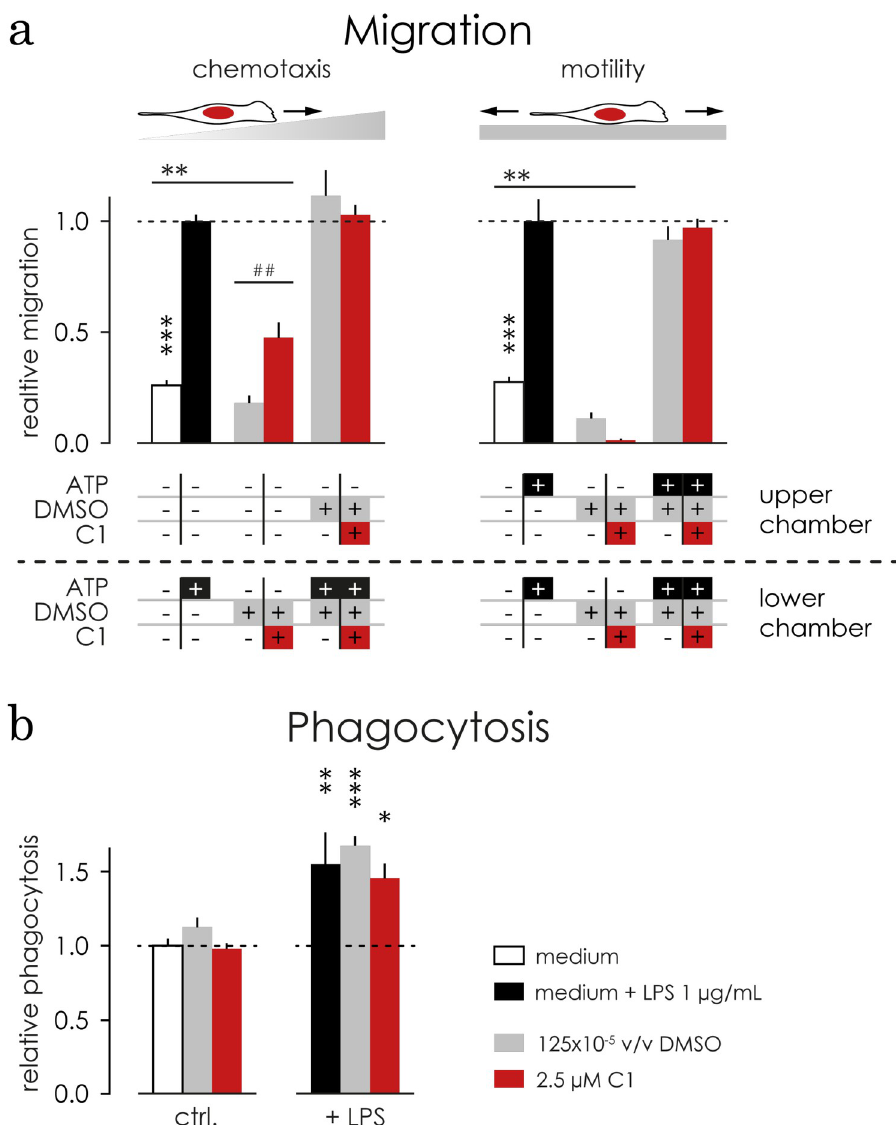
Fig 3. C1 acts as a chemoattractant but did not influence microglial motility and phagocytosis. a) C1 affected microglial chemotaxis. The results were normalized to ATP induced (black bars) chemotaxis or motility, respectively. A gradient of 2.5 μ M C1 (in red) increased chemotaxis significantly compared to plain medium (in white, p = 0.0036) and DMSO (in grey, p = 0.0012). 2.5 μ M C1 did not affect ATP induced chemotaxis in microglia. b) C1 (in red) significantly decreased microglial motility when compared to plain medium (white, p = 0.0018) but not to DMSO (grey). ATP induced motility did not change in the presence of C1 or DMSO. ��� p < 0.001 �� p < 0.01 comparing to stimulated control, ### p < 0.001 ## p < 0.01 comparing to DMSO (1way ANOVA followed by Bonferroni’s post-hoc test). c) The phagocytic activity both under basal conditions (left, ctrl.) and LPS stimulated conditions (right, +LPS) was assessed using a FACS-based protocol. Microglia were pre-treated with 2.5 μ M C1 in DMSO (red) or its corresponding concentration of DMSO (in grey,125x10 -5 v/v) and compared to the control medium. Neither C1 nor DMSO altered microglial phagocytosis significantly compared to plain medium (white). Upon stimulation with 1 μ g/ mL LPS for 24 hours phagocytosis increased significantly around 60% compared to their own unstimulated control (plain medium: +55% p = 0.0066, DMSO: +67% p = 0.0068, C1: +45% p = 0.0163, black striped bars). Within LPS stimulated conditions there were no significant differences. ��� p < 0.001 �� p < 0.01 compared to plain medium control (non-matching 2way ANOVA followed by Sidak